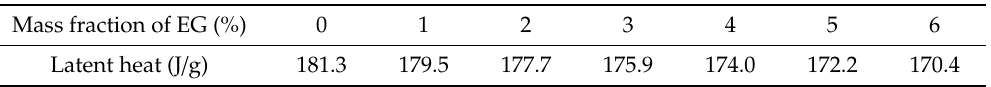
Table 2. The latent heats of LA-TD-HD / EG CPCMs with different mass fraction of expanded graphite (EG). Mass fraction of EG (%)